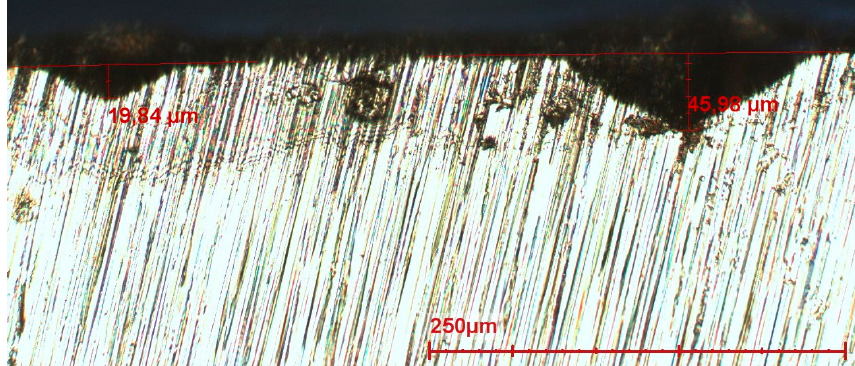
Figure 13. Cross-sectional view at pits for samples B3 in SW for 28 days.